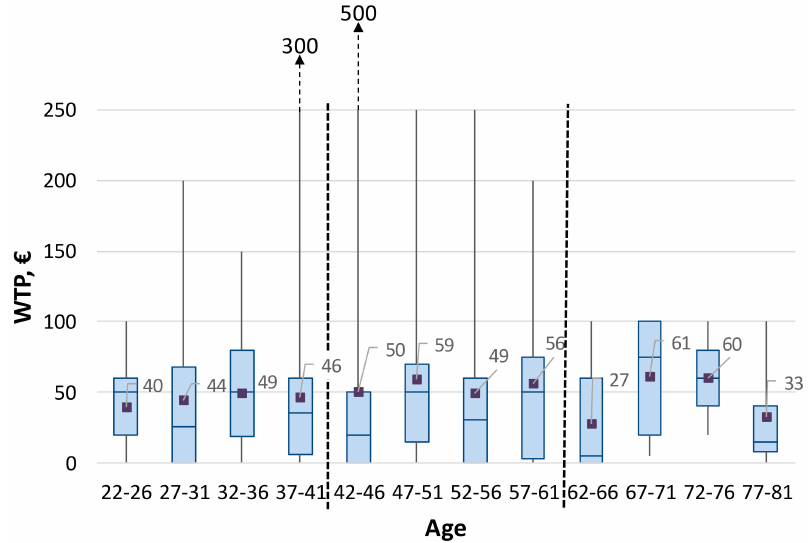
Figure 12. Distribution of WTP with respect to respondent